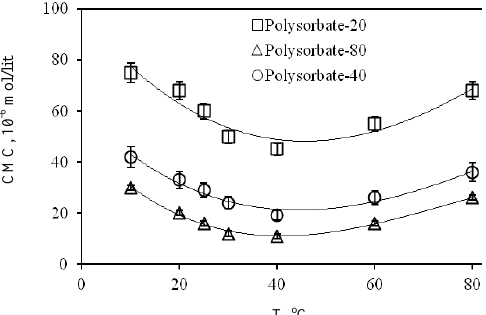
Figure 2. The variation of CMC as a function of temperature for different